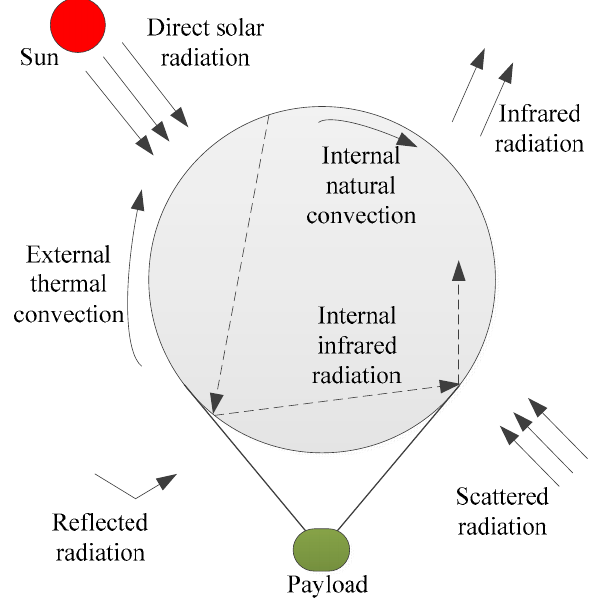
Figure 4. Thermal balance of a near-space aerostat.